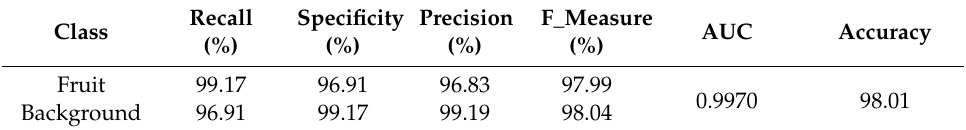
Table 11. The performance of the MV method based on di ff erent criteria in the best state of training for the testing data.